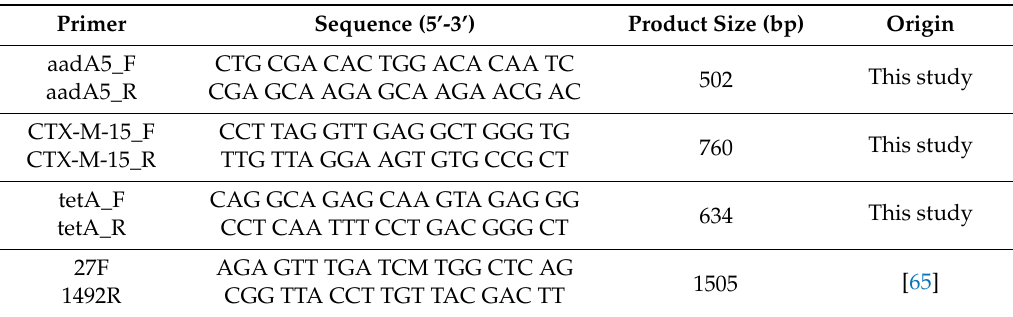
Table A1. Primers for triplex PCR detection of aadA5 , bla CTX-M-15 , and tetA present on plasmid pEK499 and amplification of 16S rRNA gene.